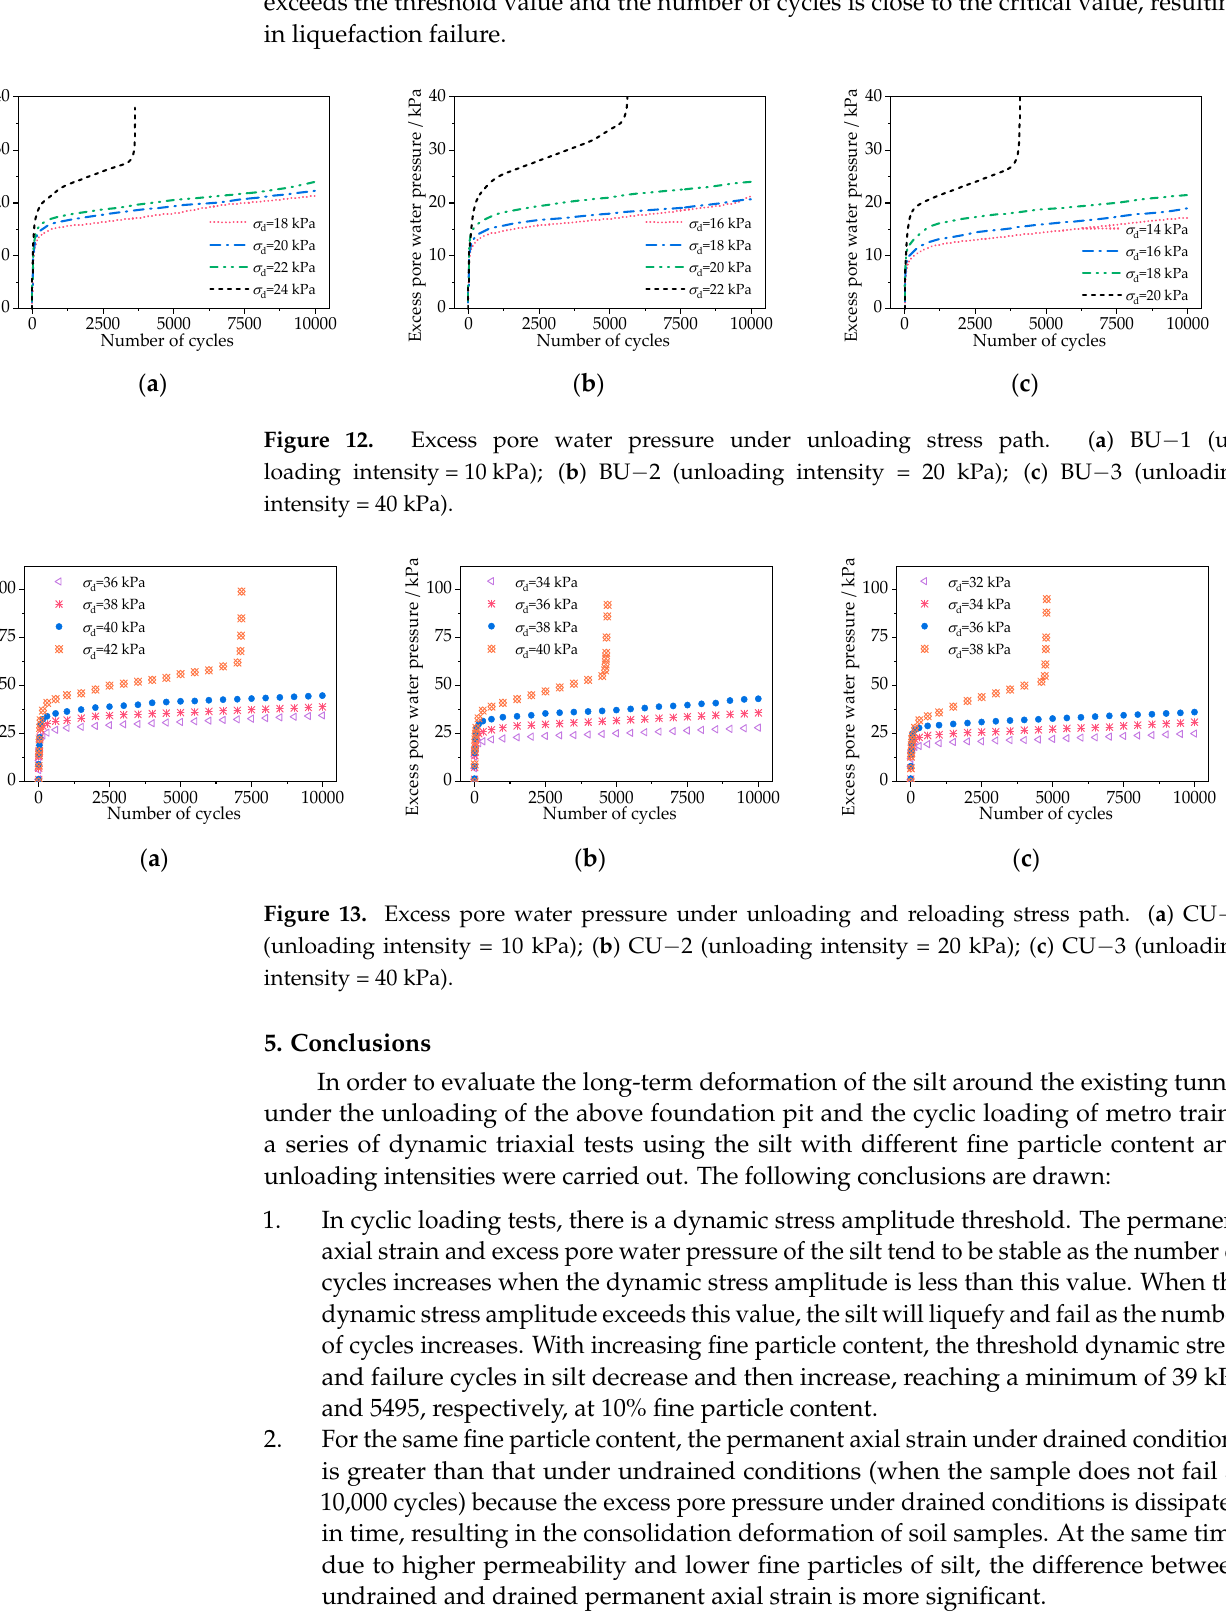
Figure 11. Threshold dynamic stress amplitude and failure cycles under different stress paths.